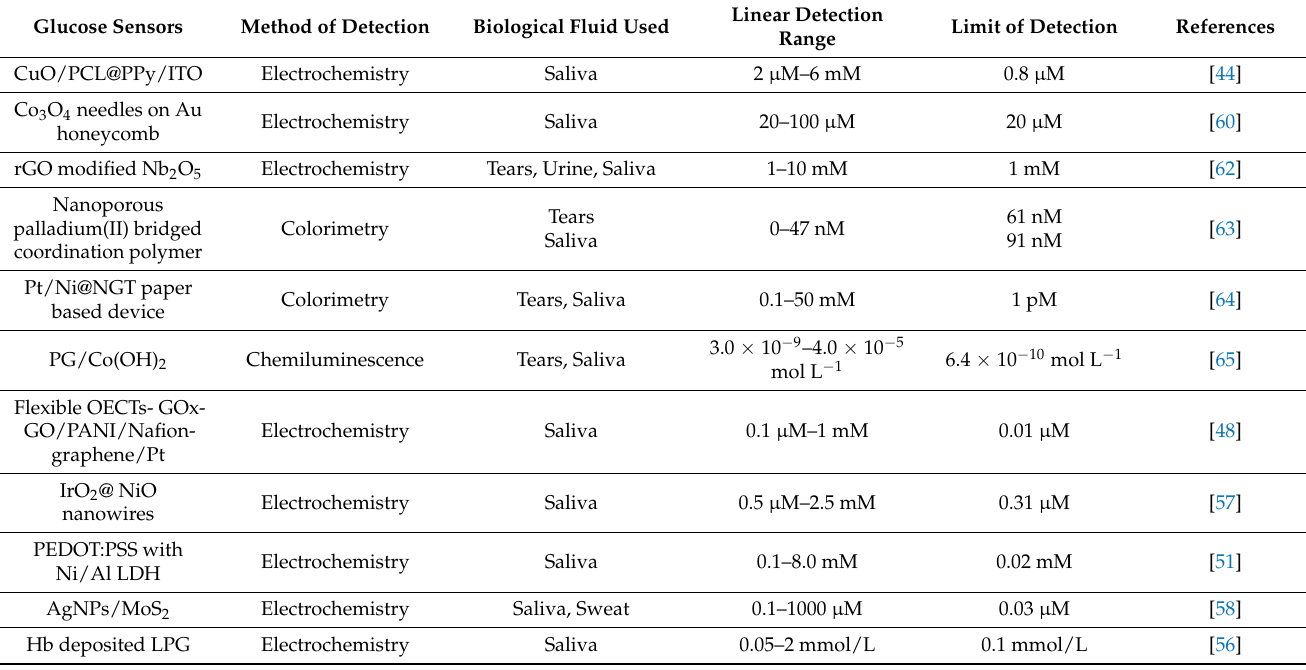
Table 1. The performance of various saliva-based glucose